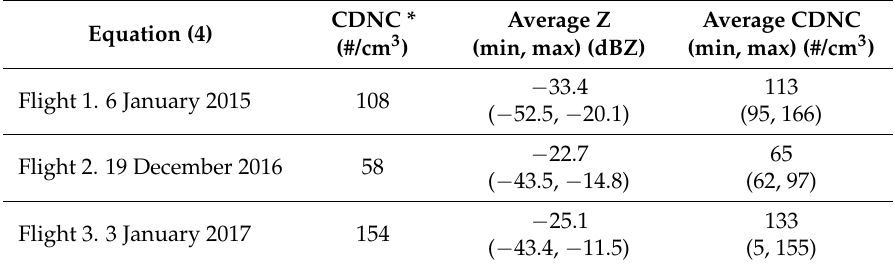
Table 5. Cloud droplet number concentration (CDNC) derived with Equation (6) for LWC and Re derived from Equations (3) and